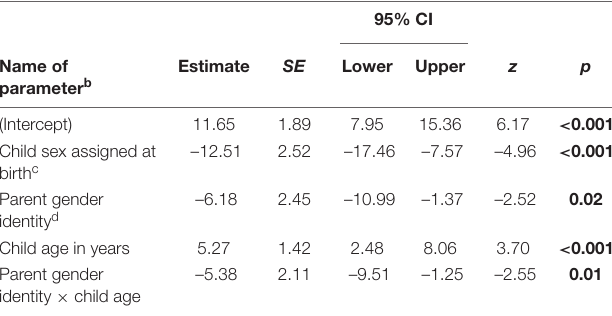
TABLE 3 | Final linear regression model predicting child gender expression scores a